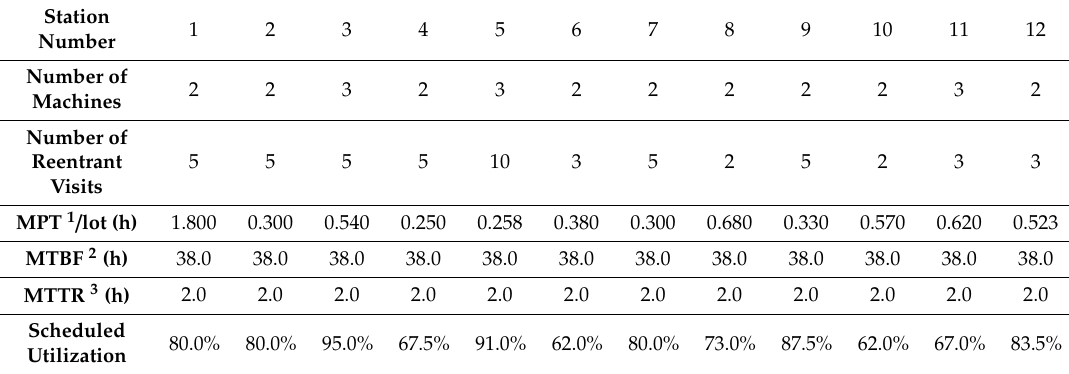
Table 1. Summary of The Basic Simulation